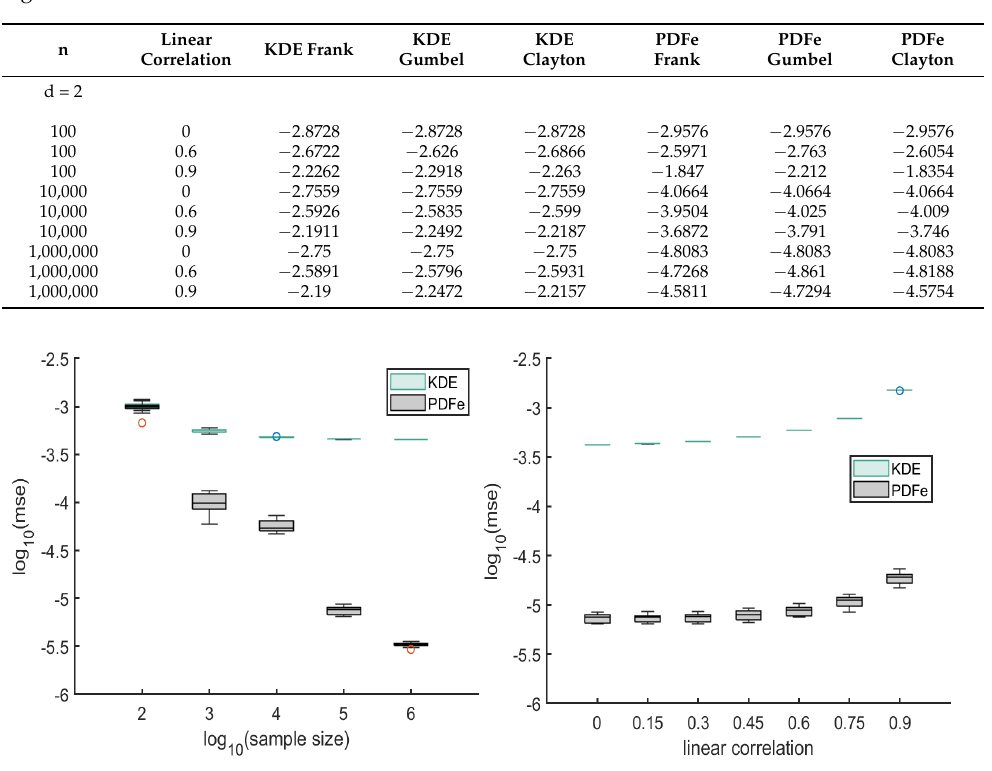
Figure 4. Mean squared error (MSE) for two variable synthetic data from Cauchy and GMM averaged over five different copulas. No correlation ( left ), sample size of 100,000 ( right